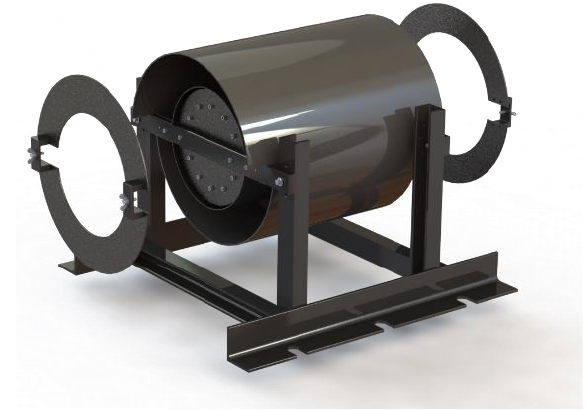
Fig. 14. Visualization of measuring stand .